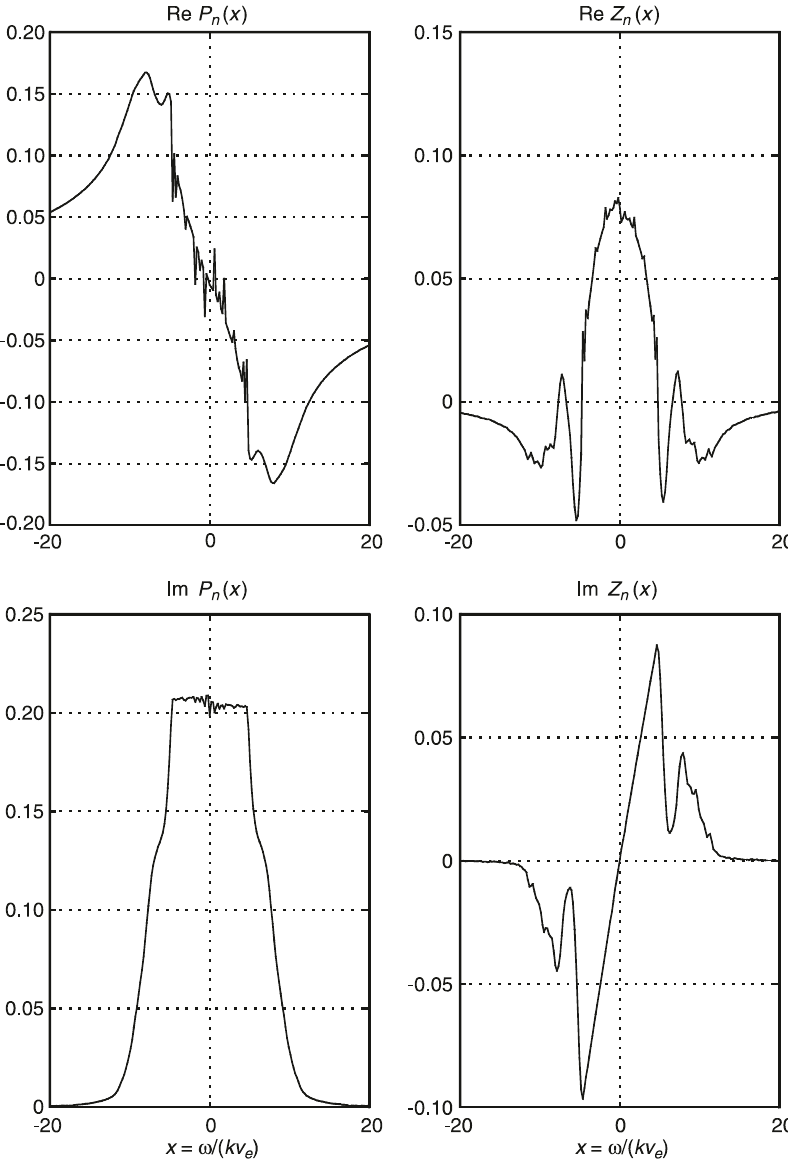
Fig. 9. On the left, the real and imaginary parts of Z n for real argument and on the right, the real and imaginary parts of P n for real argument of a suprathermal distribution at the altitude of 202 km. These calculations were performed using a 32-stream calculation of the transport code and the distribution function was then recalculated over 1024 double-Gauss points in order to perform the calculations of P n and Z n over this (cid:108)